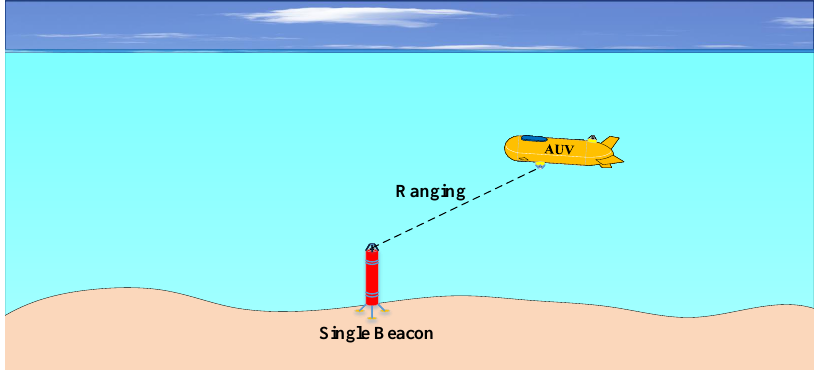
Figure 1. Illustration of framework of single-beacon